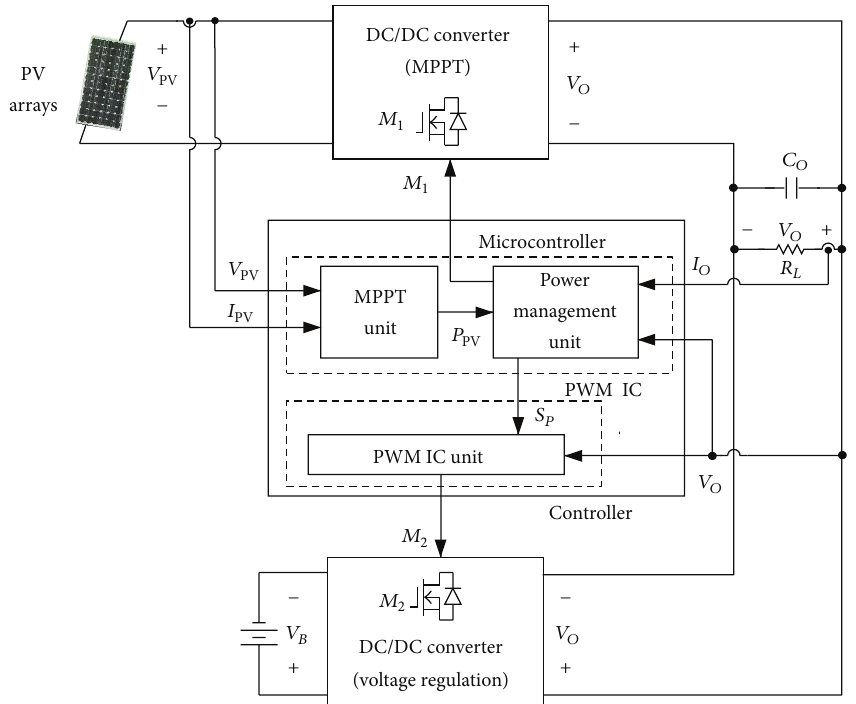
Figure 5: Block diagram of the proposed PV power conversion system.